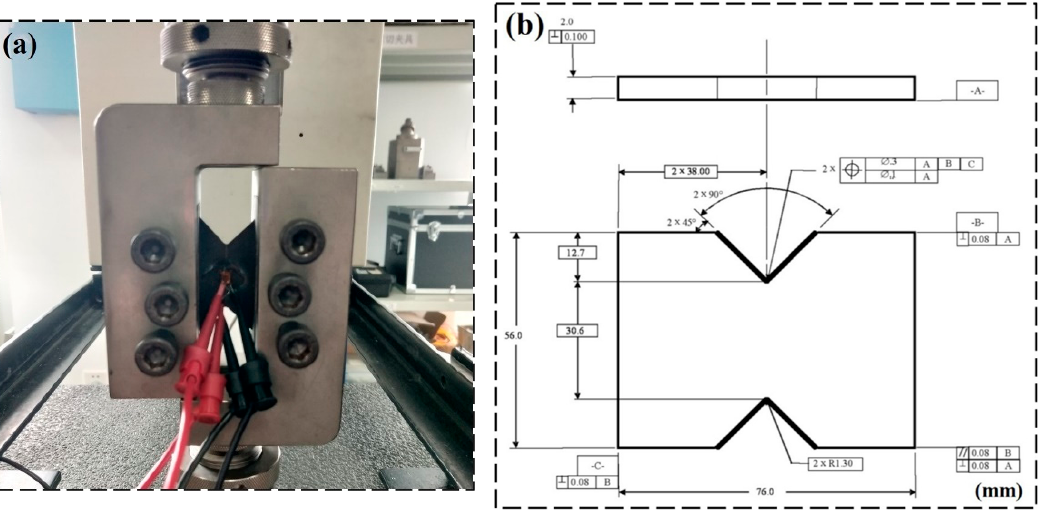
Figure 6. ( a ) V-notched rail shear apparatus illustration; ( b ) V-notched rail shear specimen mechanical drawing; all dimensions in mm.